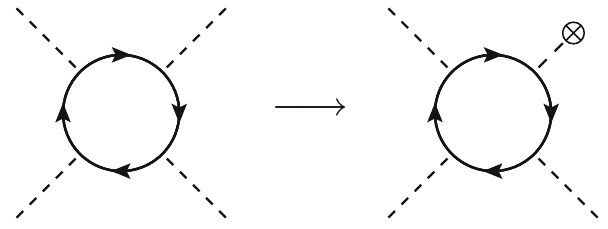
Fig. 8 Schematic view of the connection between the beta function of λ and the loop-induced trilinear Higgs self-coupling via new fermions √ √ λ ∈ [− 2 0 . 1 × 4 π, 8 π/ 3 ] from perturbativity and 3